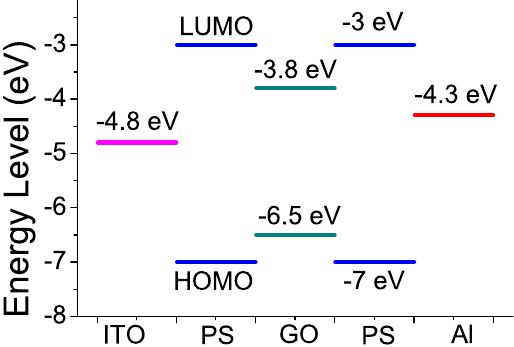
Figure 12. Energy band diagram of the ITO/PS + GO/Al